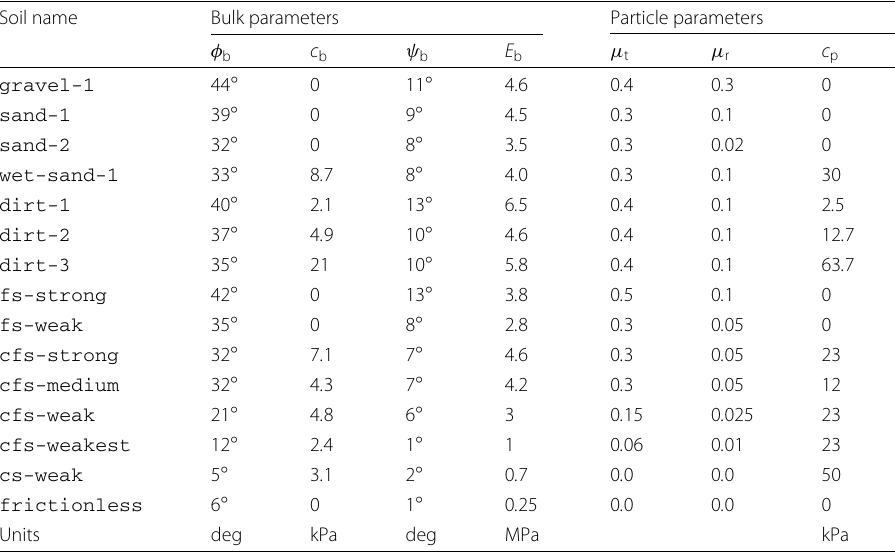
Table 1 A small library of soils with particle parameters pre-calibrated to desired bulk parameters using a triaxial test Soil